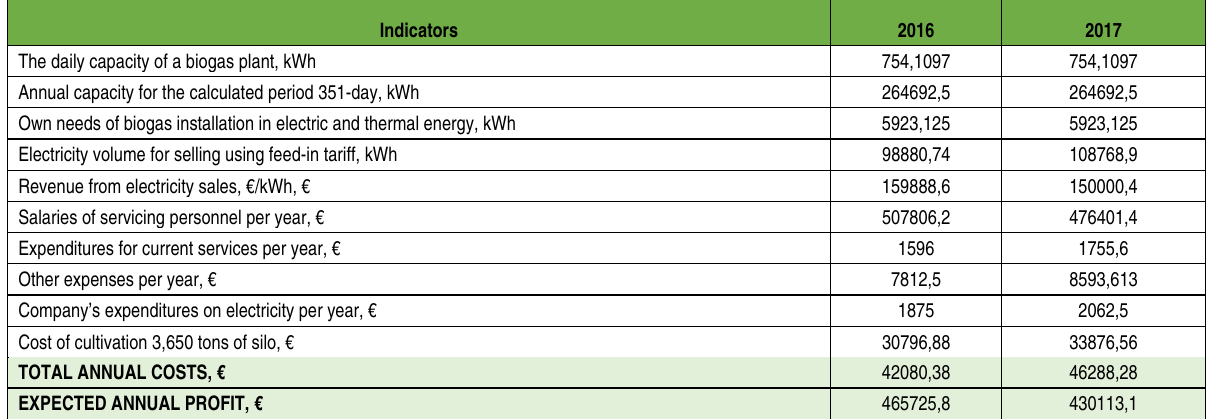
Table 9. The findings for the second scenario for years 2016–2017